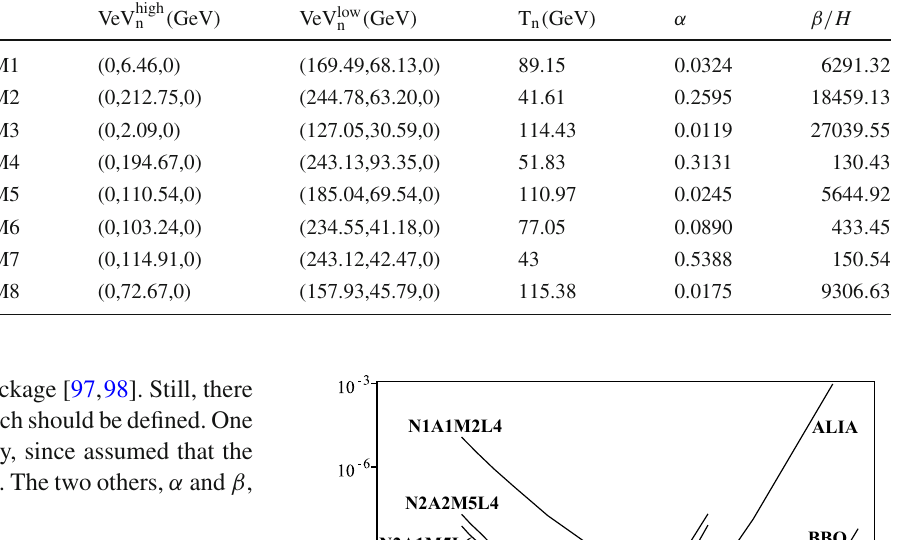
Table 3 The values of the VeV of the high and the low phases, T n , α and β/ H